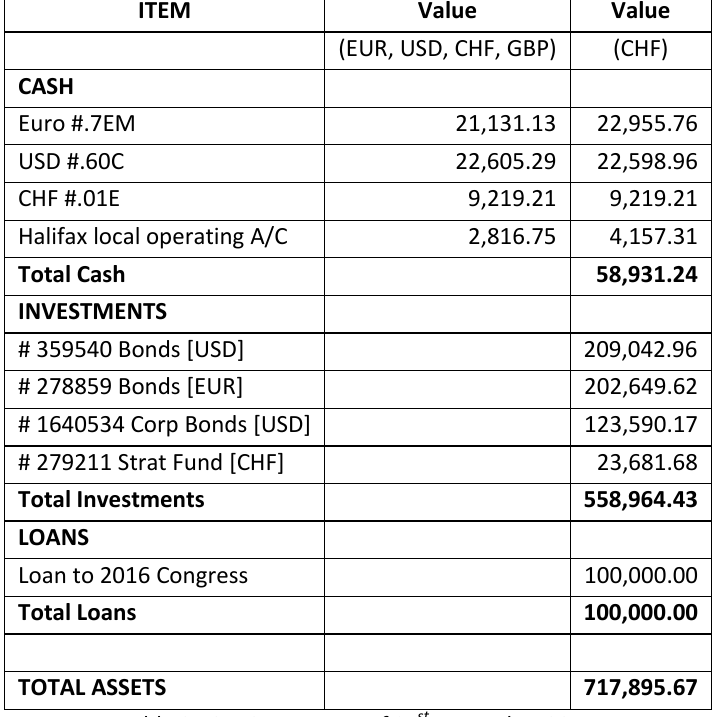
Table 2: ISPRS assets, as of 31 st December 2015